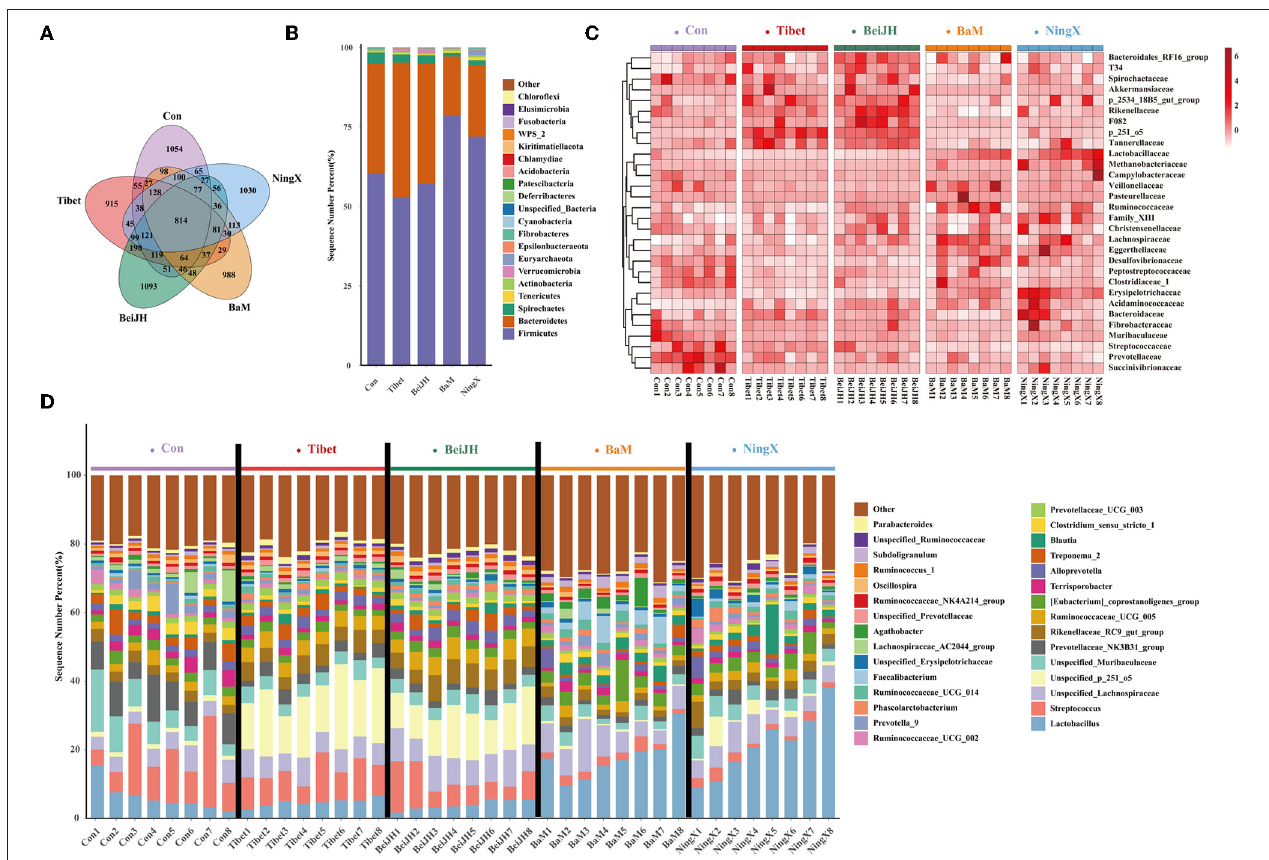
FIGURE 3 | Differential composition of microbial community among various pig breeds. (A) Venn diagram analysis of five pig breeds. (B) Histogram of species abundance at the phylum level. (C) The heat map of bacteria composition at the family level. (D) Histogram of the microbial community at the genus level.